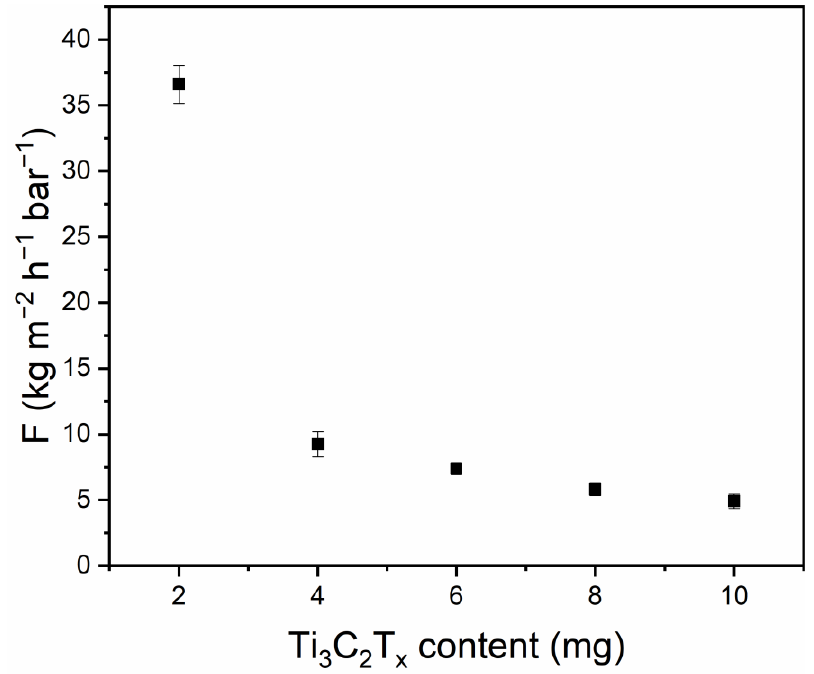
Figure 7. Pure water fluxes of the Ti 3 C 2 T x MXene membranes with different contents.